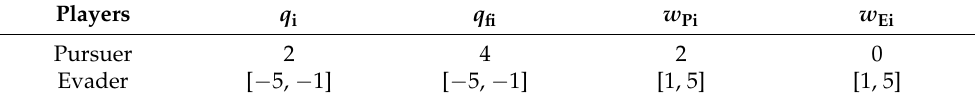
Table 5. The values and ranges of weight parameters of pursuer and evader.